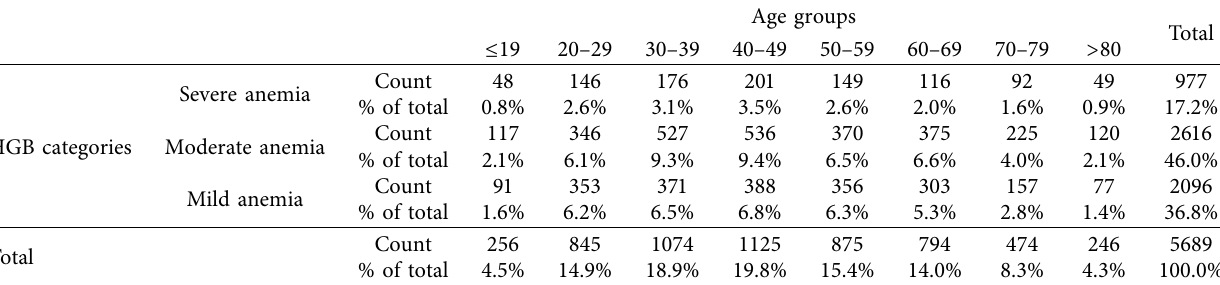
Table 4: Severity of anemia across age groups in